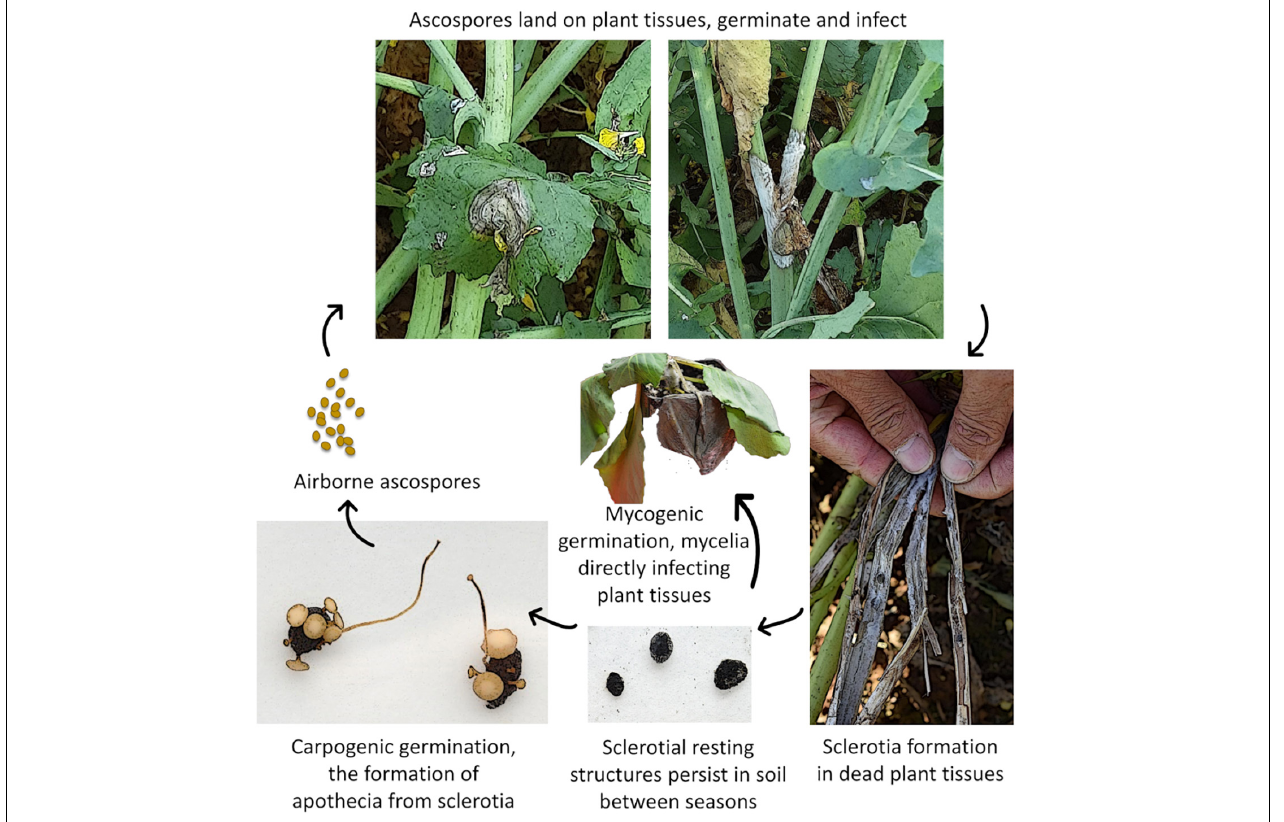
FIGURE 1 | Generalised Sclerotinia disease cycle. Image credits: Smith, 2018 CSIRO and Tian, 2020